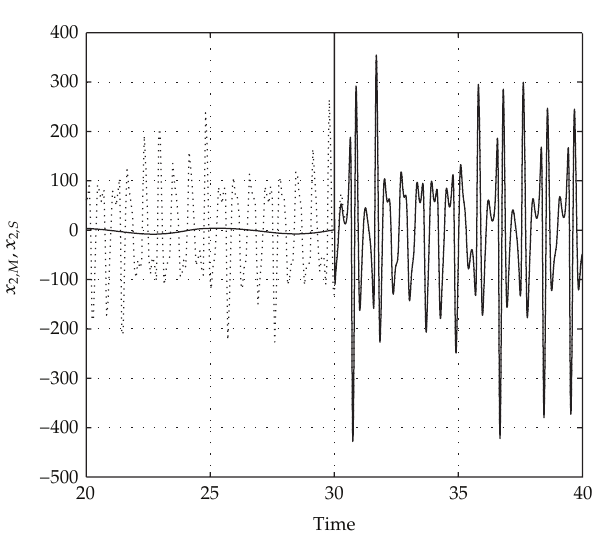
Figure 2: Synchronization between x 2 ,S and the function L F